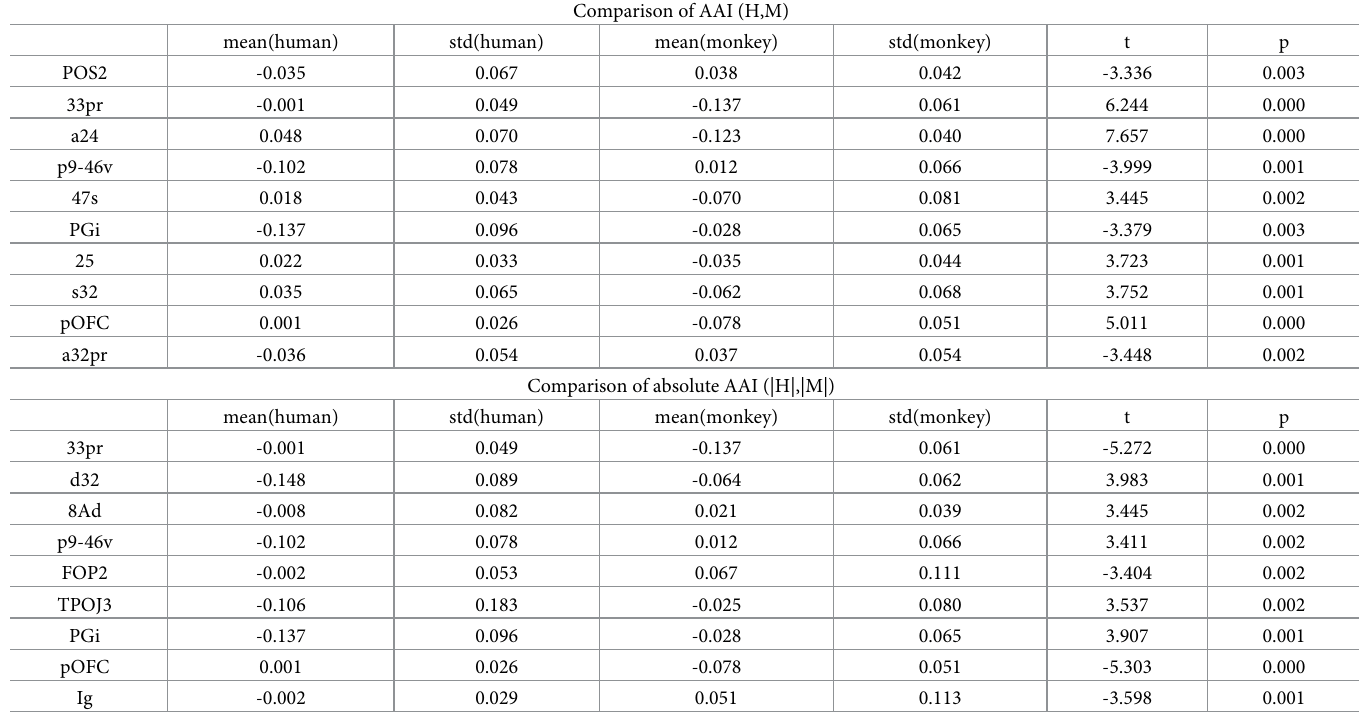
Table 2. Group differences in the interhemispheric areal asymmetry between humans and macaques.